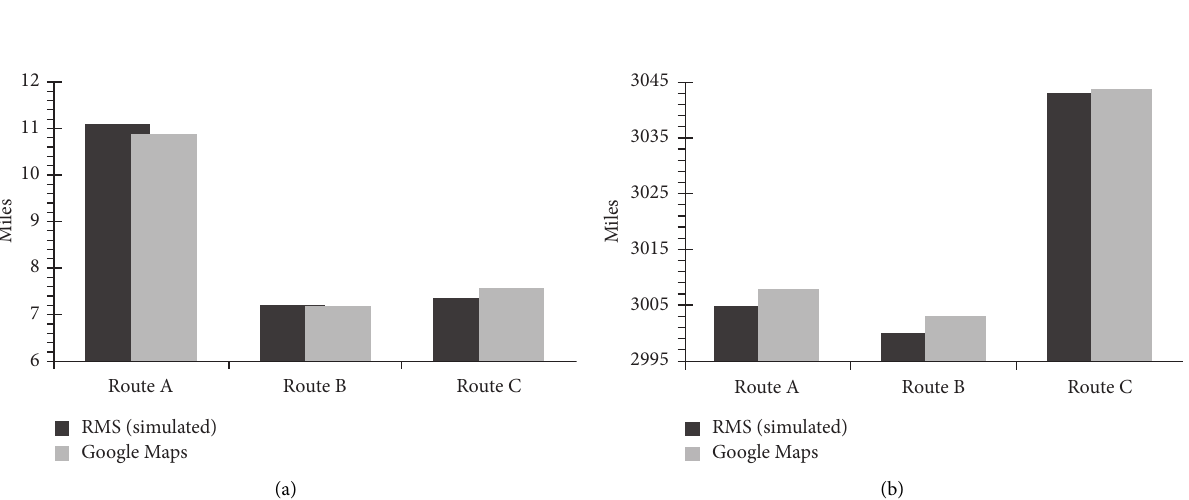
Figure 4: Distance comparison—simulation vs Google Maps. (a) Short-distance routing and (b) long-distance